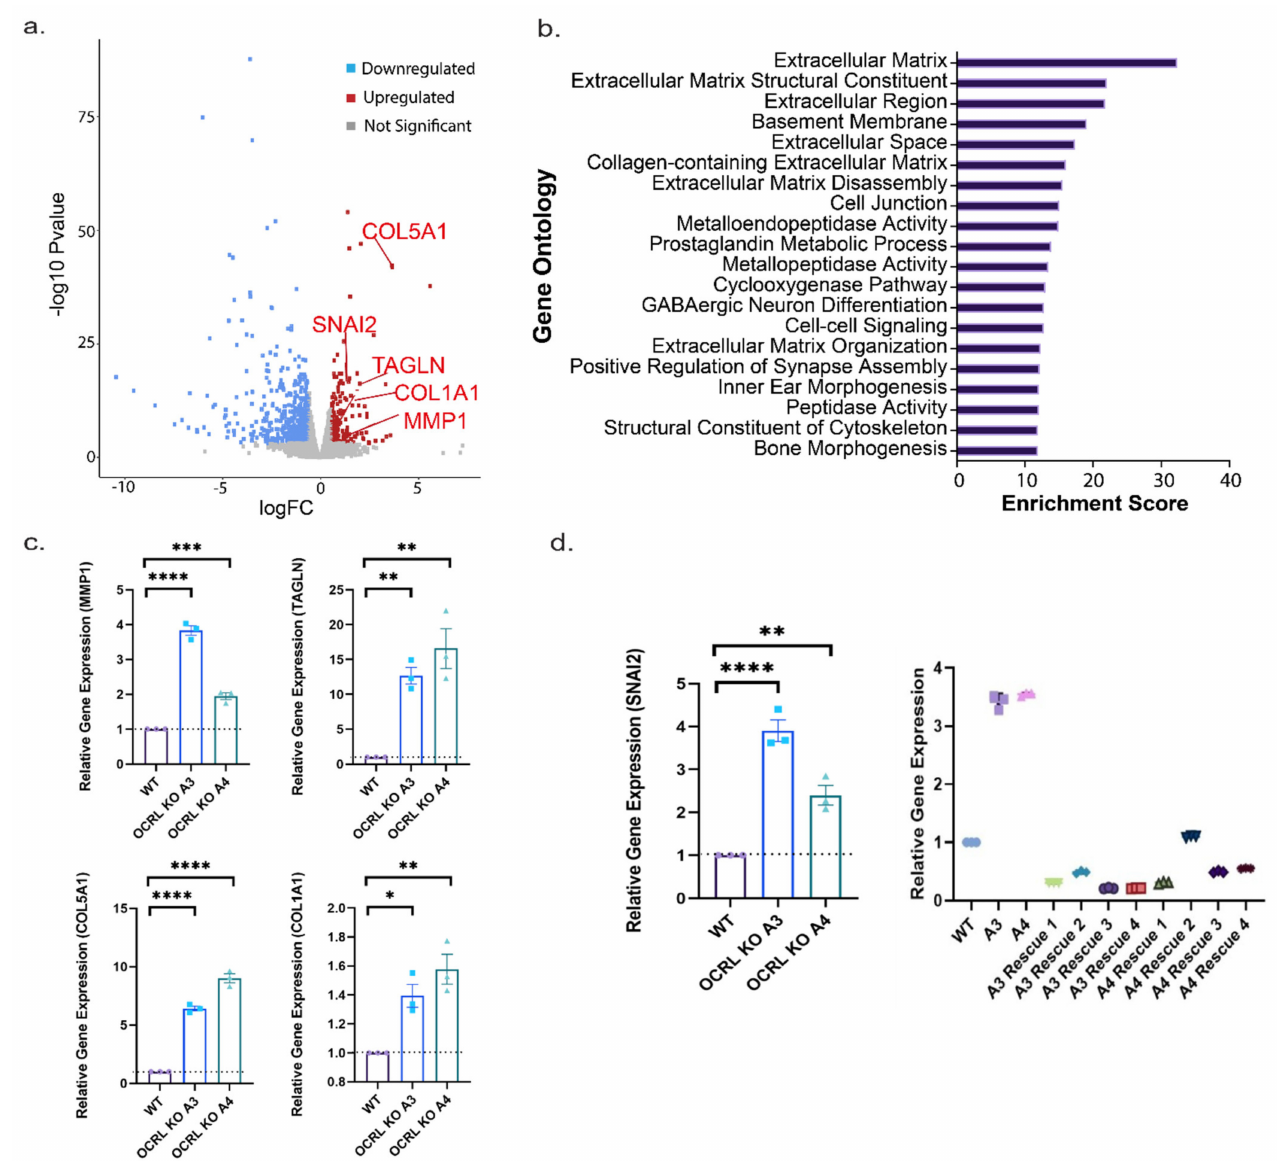
Figure 6. Differential gene expression: ( a ) volcano plot showing differentially expressed genes with a cut off of 0.5, and ECM- and EMT-related genes validated by qPCR are highlighted. ( b ) Gene Ontology (GO) terms filtered according to 161 differentially expressed genes. The highest score of 32.38, in blue, is the extracellular matrix in the cellular component. 17 (267)—17 genes on our list matched 267 known dysregulated genes in the extracellular matrix cellular component. ( c ) Other upregulated genes confirmed by qPCR. Relative gene expression was calculated by 2 − ∆∆ Ct with appropriate housekeeping genes. ( d ) SNAI2 expression was upregulated in the absence of OCRL, and the gene expression levels were reduced with the re-introduction of OCRL–GFP into the cells. Ordinary one-way ANOVA and Dunnett’s multiple comparison test, N = 3 (>50 cells per N ). *, p < 0.05; **, p < 0.01; ***, p < 0.001; ****, p < 0.0001, error bar represents mean with ±